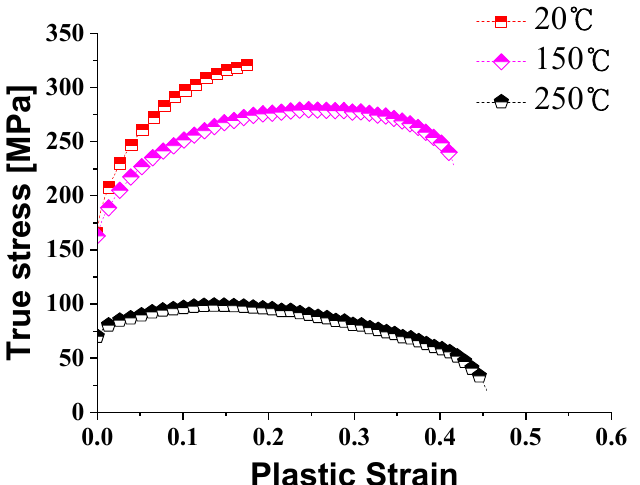
stress is about twice that of the compressive yield stress, and this difference decreases with increasing forming temperature [19].